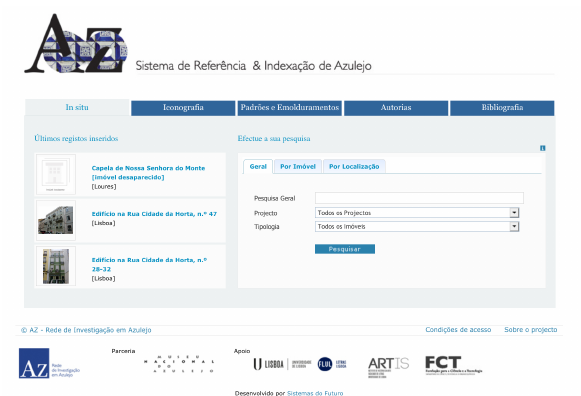
Figure 3. Homepage of Az Infinitum – Azulejo Referencing and Indexation